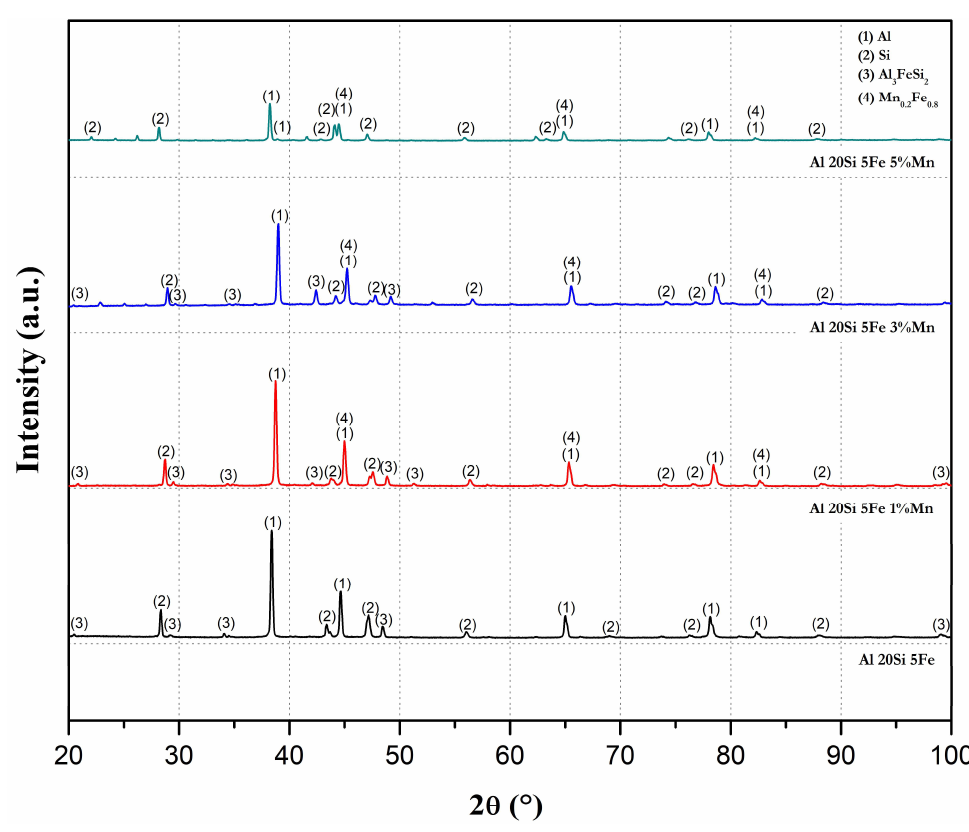
Figure 12. X-ray diffraction pattern of the Al–20Si–5Fe masters alloy and the Mn additions. Metals 2018 , 8 , x FOR PEER REVIEW